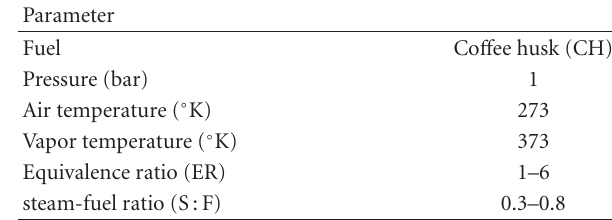
Table 2: Conditions used in atom and equilibrium